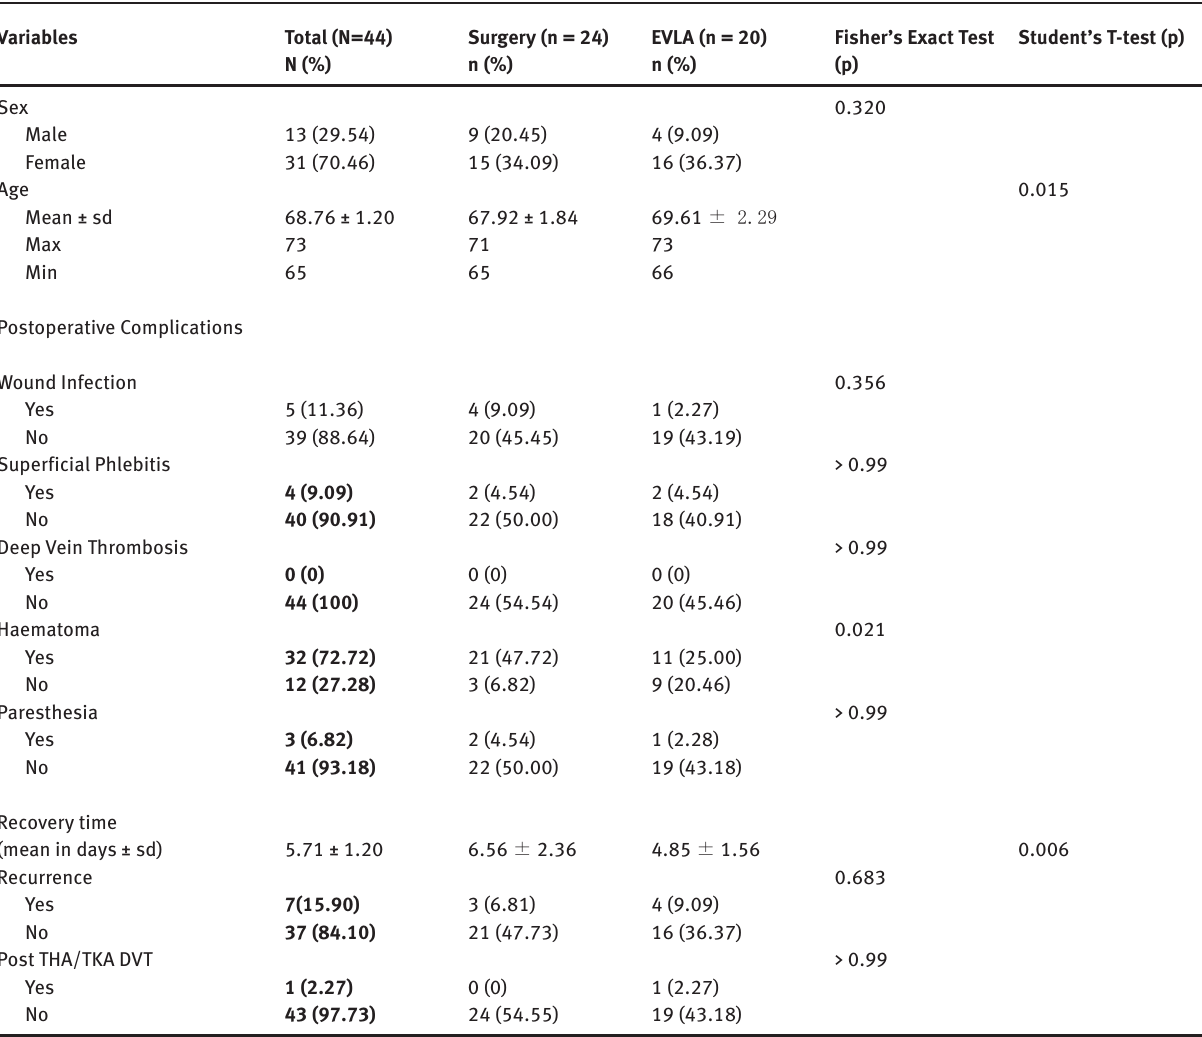
Table 1: Results of the